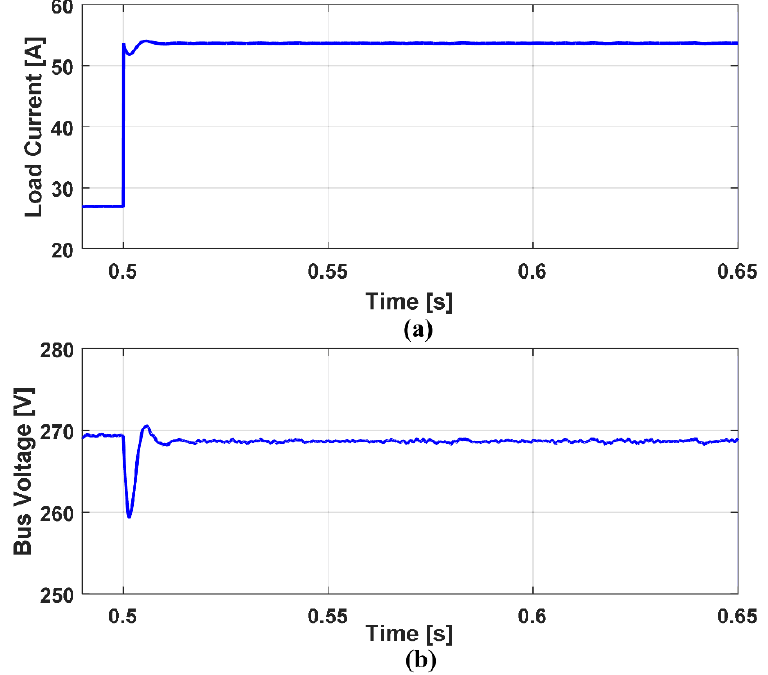
Figure 12. Simulated load current and bus voltage ( L v 2 = 1 mH). ( a ): Load Current, ( b ): Bus Voltage.